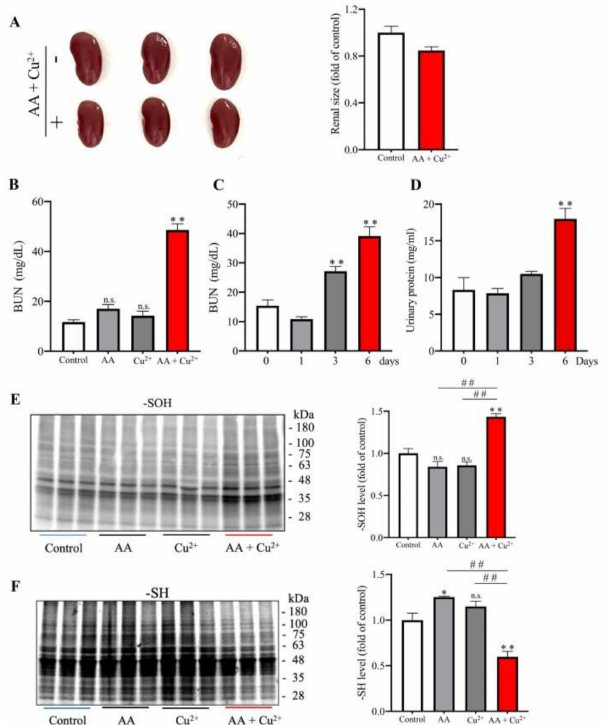
Figure 3. Effects of in vivo administration of AA and Cu 2+ on the kidney. ( A ) Effects of AA plus Cu 2+ on kidney size. Mice were administered 100 mg/kg AA or 1 mg/kg Cu 2+ or both in combination via oral gavage once a day for six days. The kidneys were photographed and measured for their sizes (area). The data shown on the right side are % changes of renal size relative to control (mean ± SE; n = 3). ( B – D ) Effects of AA plus Cu 2+ on the level of BUN and urinary proteins. Mice were administered 100 mg/kg AA or 1 mg/kg Cu 2+ or both in combination via oral gavage once a day for five ( B ) or six days ( C , D ). The level of BUN and urinary proteins was measured. Data shown are mean ± SE ( n = 3–6; n.s.: not significant; ** p < 0.01 vs. control). ( E , F ) Effect of AA and Cu 2+ on the level of -SOH formation and -SH groups in the kidney. The result of the densitometric analysis is shown on the right side of the blot. Mice were administered with 100 mg/kg AA or 1 mg/kg Cu 2+ or both in combination via oral gavage once a day for five days. The level of -SOH formation and -SH groups in kidney lysates were measured. Data shown are mean ± SE ( n = 3–4; n.s.: not significant; * p < 0.05; ** p < 0.01 vs. control; ## p <